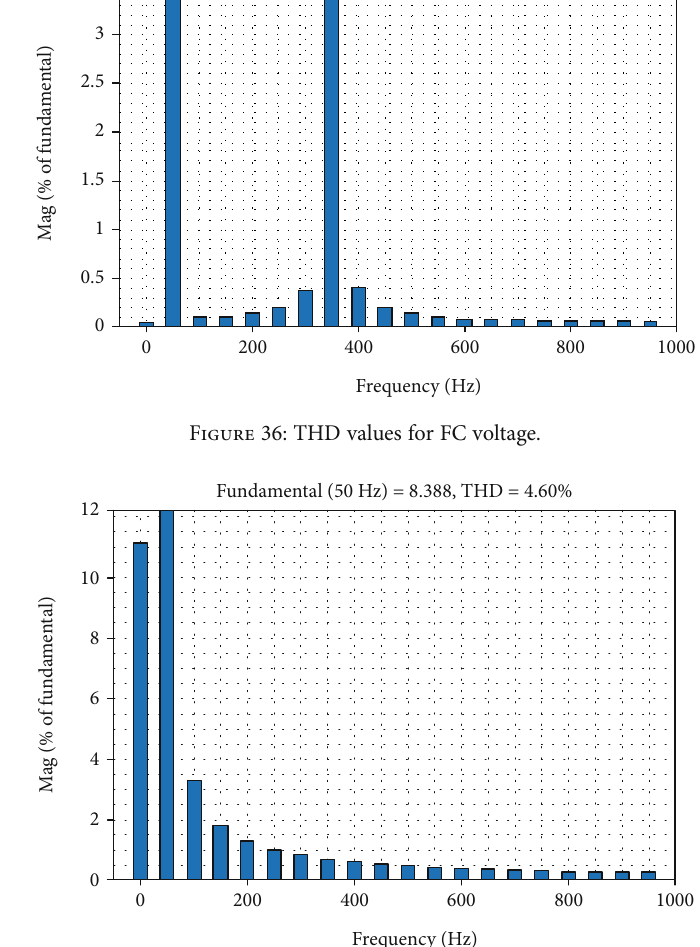
Figure 37: THD values for FC